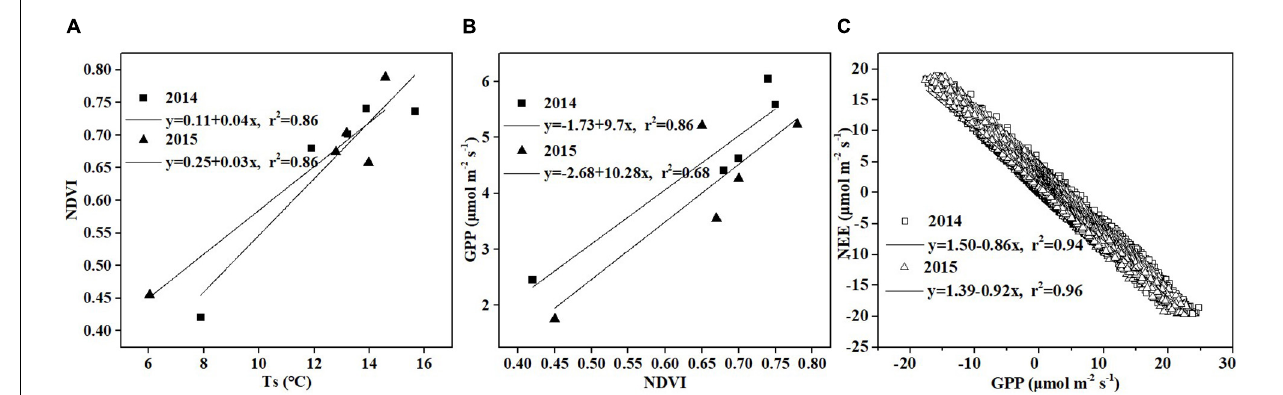
FIGURE 10 | Relationship between (A) Ts and NDVI, (B) NDVI and GPP, and (C) GPP and NEE.